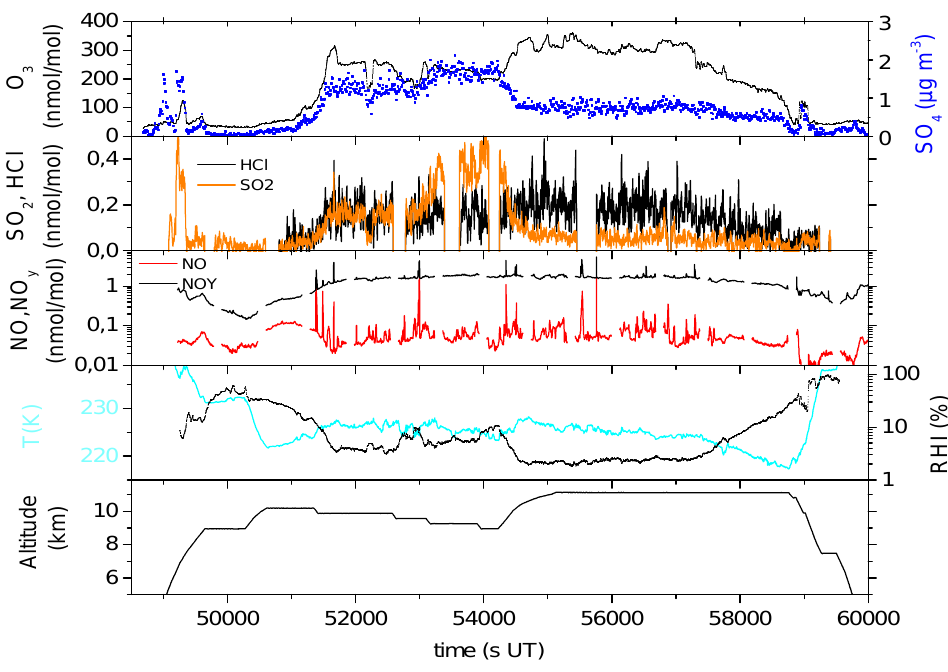
Fig. 12. Altitude, temperature, RH I , NO, NO y , O 3 , SO 2 , HCl, and sulfate concentrations detected on 31 October 2008 on flight B from Shannon to Oberpfaffenhofen. Large scale aircraft emissions in the lowest stratosphere and the aged eruption plume from volcano Mt. Kasatochi have been